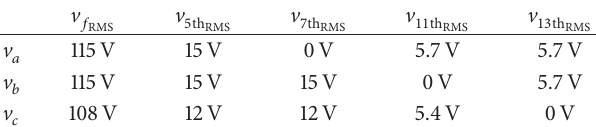
Table 1: Harmonic distortion in the voltage source per